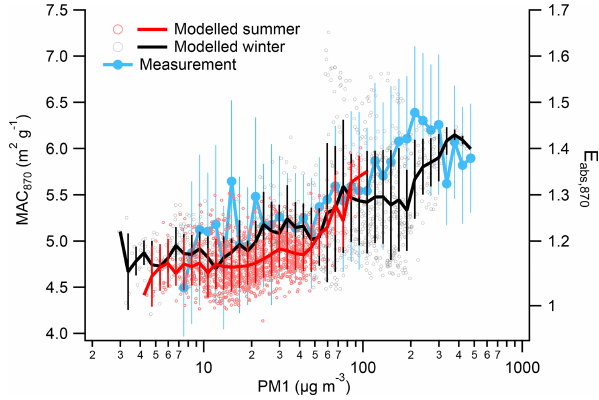
Figure 13. The modelled and measured MAC 870 and E abs at dif- ferent pollution